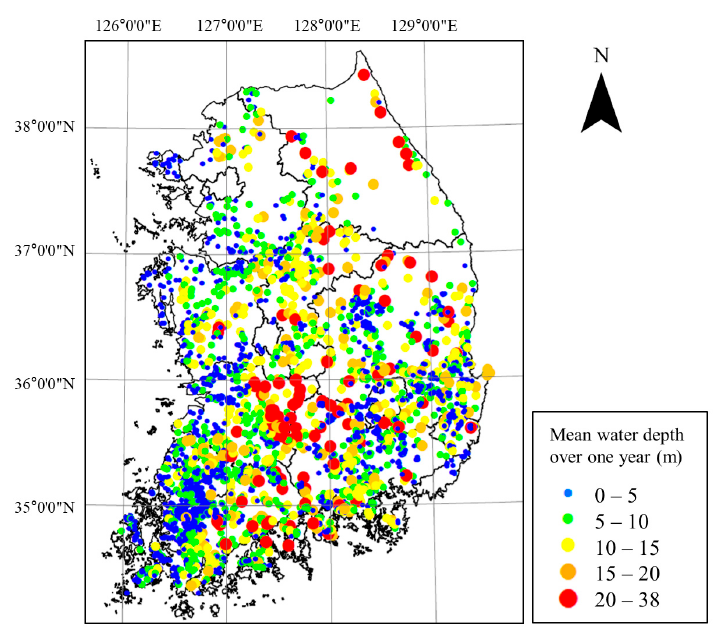
Figure 8. The map of the average water depth for each reservoir over a year.